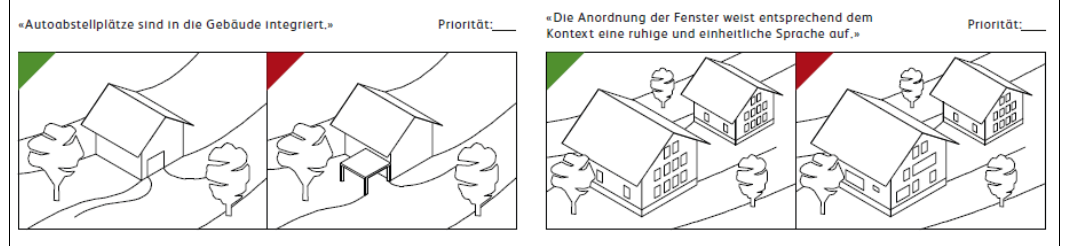
Figure 7: Extract from the rating sheet distributed to participants of the first workshop Source: